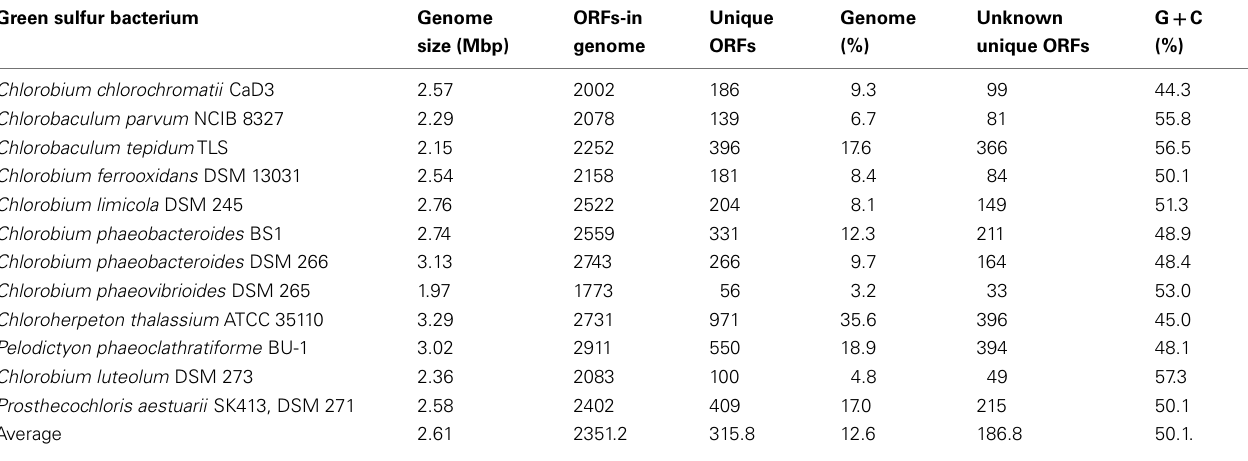
Table 1 | Comparison of green sulfur bacterial genomes against each other. Green sulfur bacterium Genome